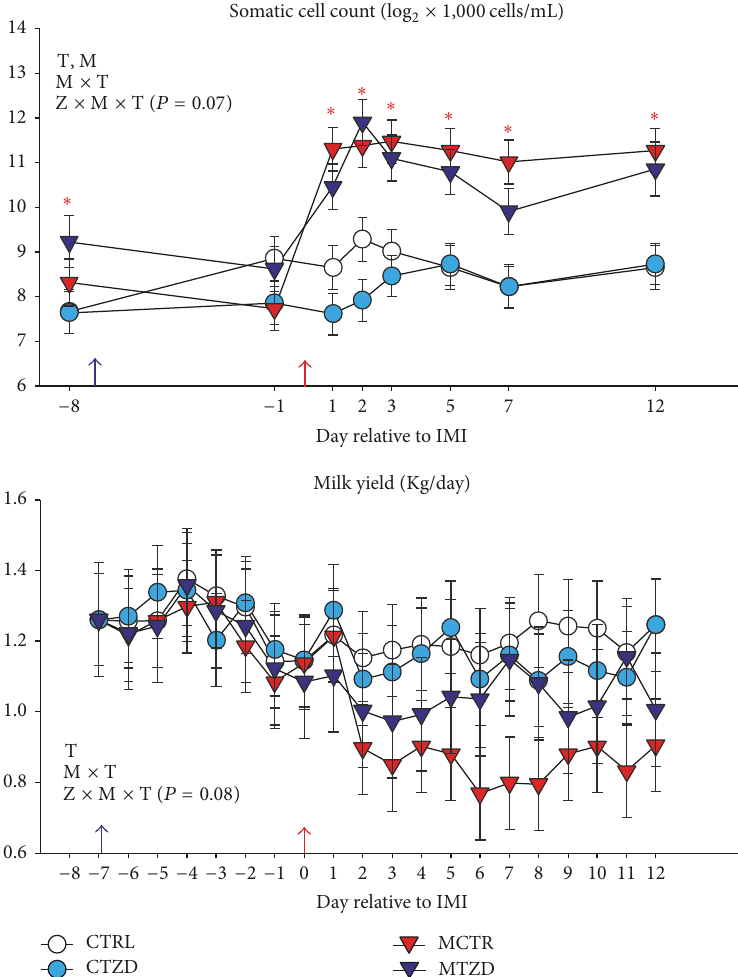
Figure 3: Milk somatic cell count and milk yield measurements from − 8 to 12 d relative to intramammary infusion of Strep. uberis (M) or saline in goats receiving daily intrajugular injection of 2,4-thiazolidinedione (TZD) or saline (CTR). Significant ( 𝑃 ≤ 0.05 ) effects and interactions are indicated in the graph (mastitis, M, time: T, and TZD, Z). The 𝑃 value for tendency is reported. Significant effect of M × T is denoted with red